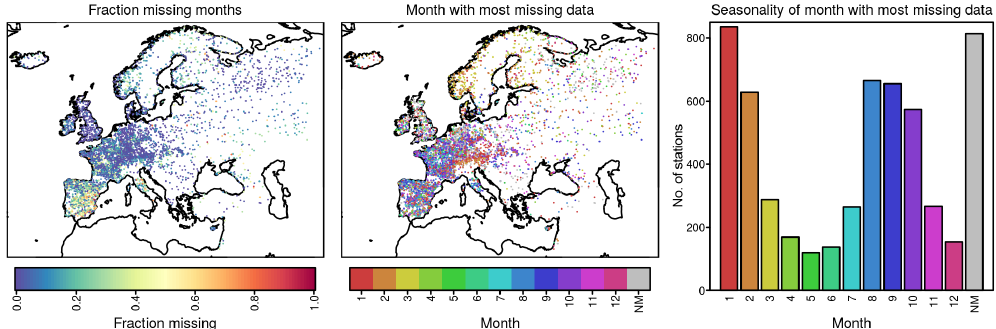
Figure 3. Overview on the spatial and seasonal distribution of missing months. Shown are the fraction of missing months at each station (left), the month which has on average most missing values at each station (centre) and the regional frequency distribution of the months with the most missing values (right). NM indicates no missing values.